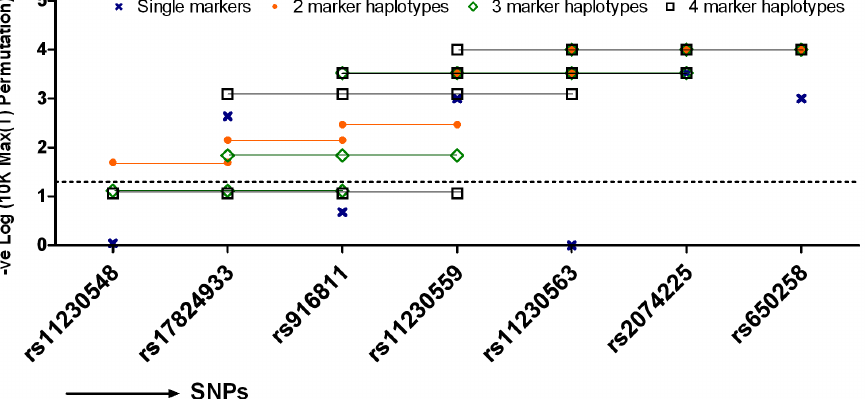
Figure 3. Sliding window haplotype analysis using (A) two and (B) three markers by means of max(T) permutation analysis. A sliding window analysis tests the overall association of the two/three markers that are located adjacent to each other shifting one marker at a time. The analysis was done using the combined dataset containing 3088 cases/3414 controls from the three replication sample sets and the original dataset for the six SNPs selected for replication.